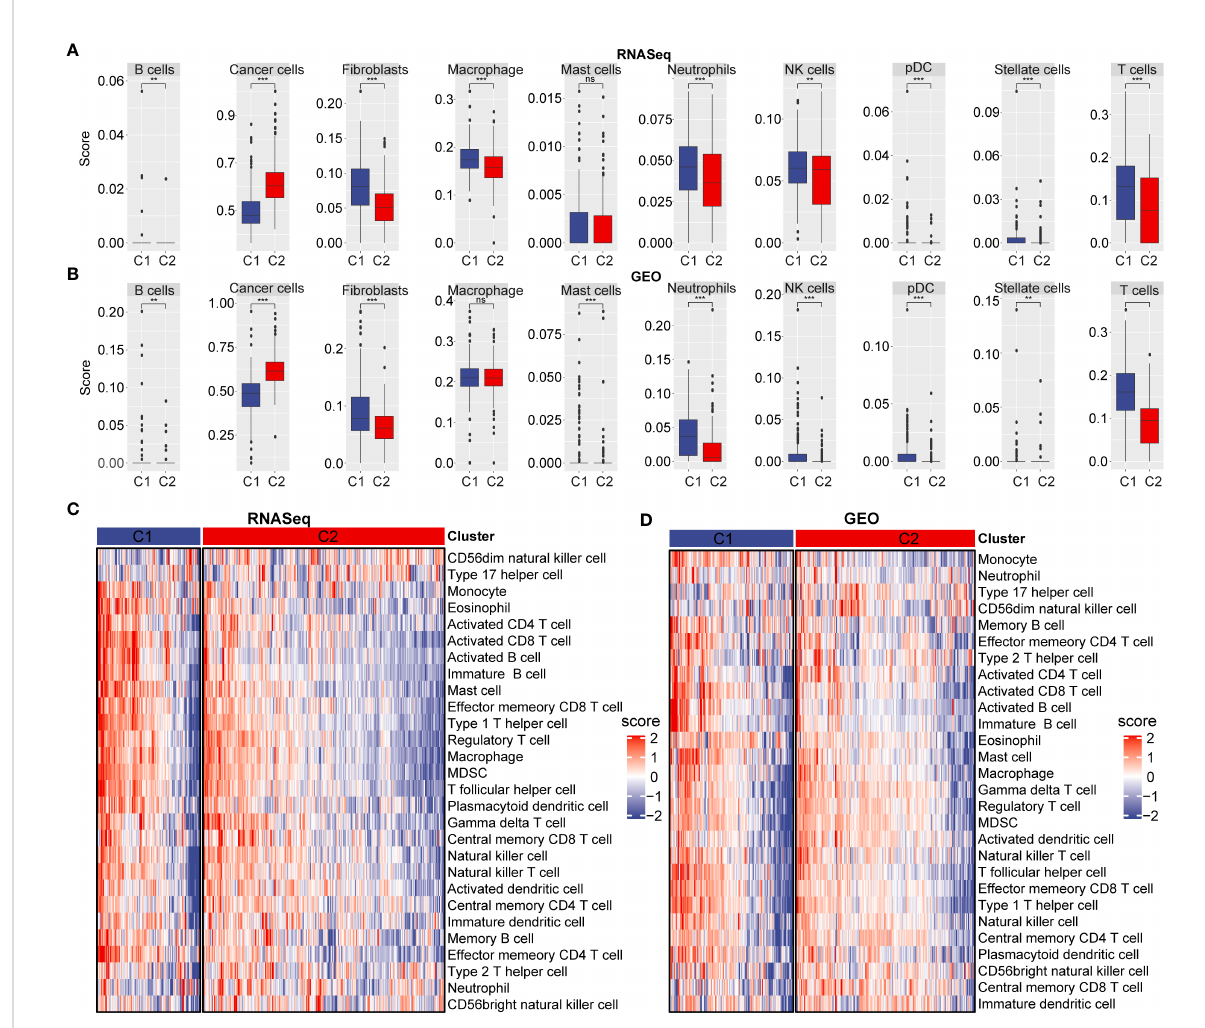
FIGURE 4 Immune cell scores and heat map of immune microenvironment score. (A) Cell score between C1 and C2 subtype in RNA-seq dataset. (B) Cell score between C1 and C2 subtype in GEO database. (C) Differences in heat map distribution of ssGSEA immune microenvironment score in subtypes. (D) Heatmap distribution differences of ssGSEA immune microenvironment score in GEO dataset in subtypes. ** p < 0.01; *** p < 0.001; ns, no signi fi